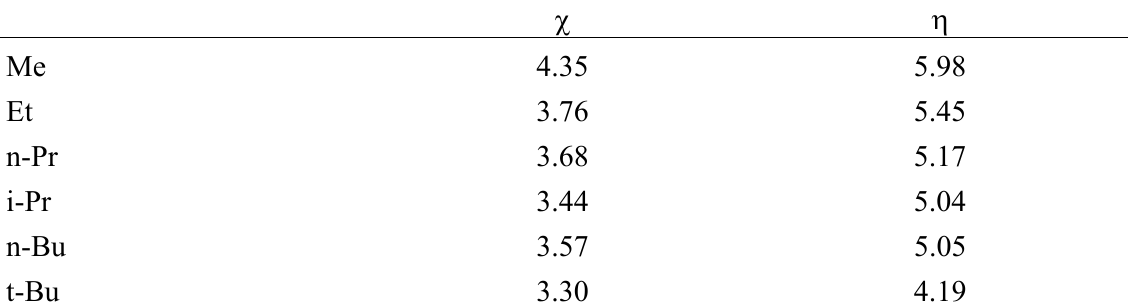
Table 1. 6-31G* MP4 alkylgroup properties : electronegativity χ (eV) and hardness η (eV)